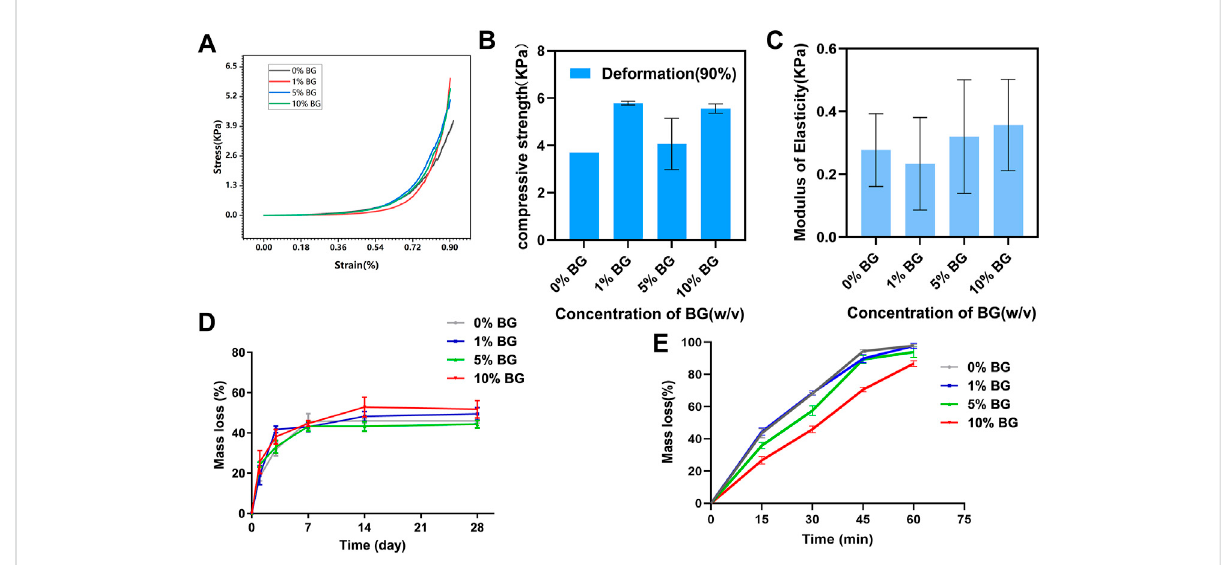
FIGURE 5 Mechanical and degradation properties of the biomimetic BG/GelMA scaffolds (A) Representative compressive stress – strain curve of the biomimetic BG/GelMA scaffolds. Grey: 0% BG group; Red: 1% BG group; Blue: 5% BG group; Green: 10% BG group; (B) Compressive strength of the scaffoldsatthedeformationof90%; (C) Elasticmodulusofthescaffolds.N=3samplespergroup; (D) Invitro degradationinPBSsolutionat37 ° Cand (E) enzymatic degradation of scaffolds 0% BG, 1% BG, 5% BG, and 10% BG. Grey: 0% BG group; Blue: 1% BG group; Green: 5% BG group; Red: 10% BG group; Data represent the mean ± SD, n =